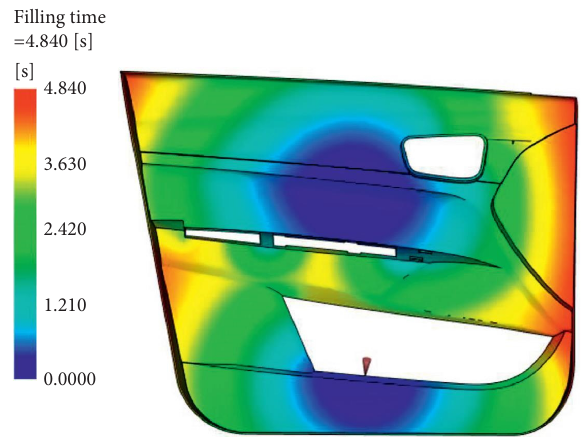
Figure 13: Optimized filling time